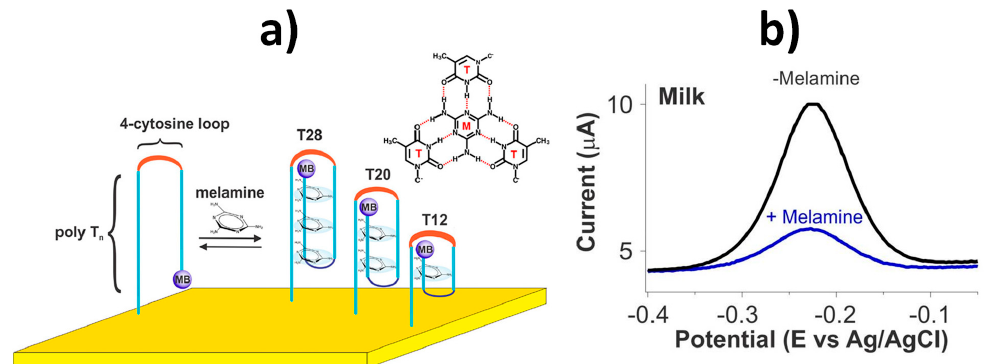
Figure 8. ( a ) Electrochemical switch-based sensor developed for melamine monitoring using a family of redox reporter (methylene blue, MB) modified, thiol-anchored DNA sequences comprised of two polythymine segments connected by a four-cytosine loop. ( b ) SWVs obtained in the absence and presence of 500 μ M melamine. Reprinted from [35], with permission.